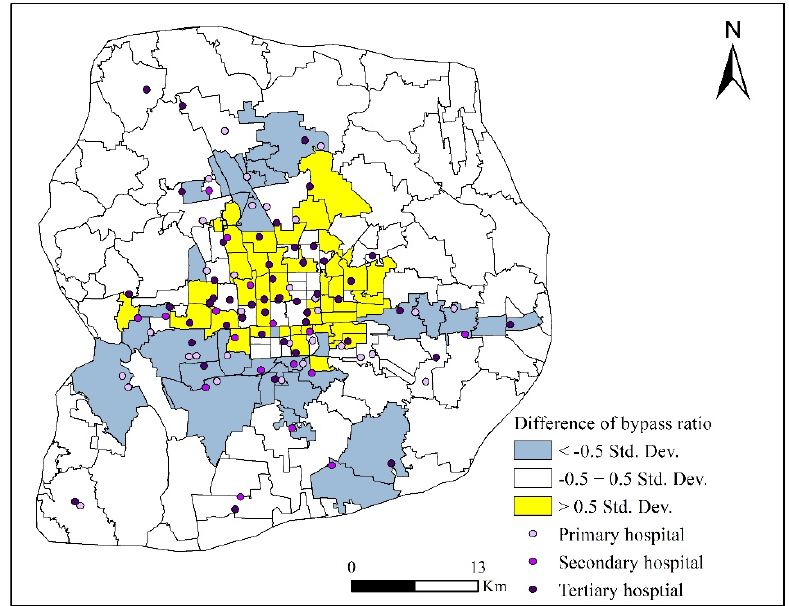
Figure 4. Spatial difference between hospital bypass ratios pre-reform and post-reform.